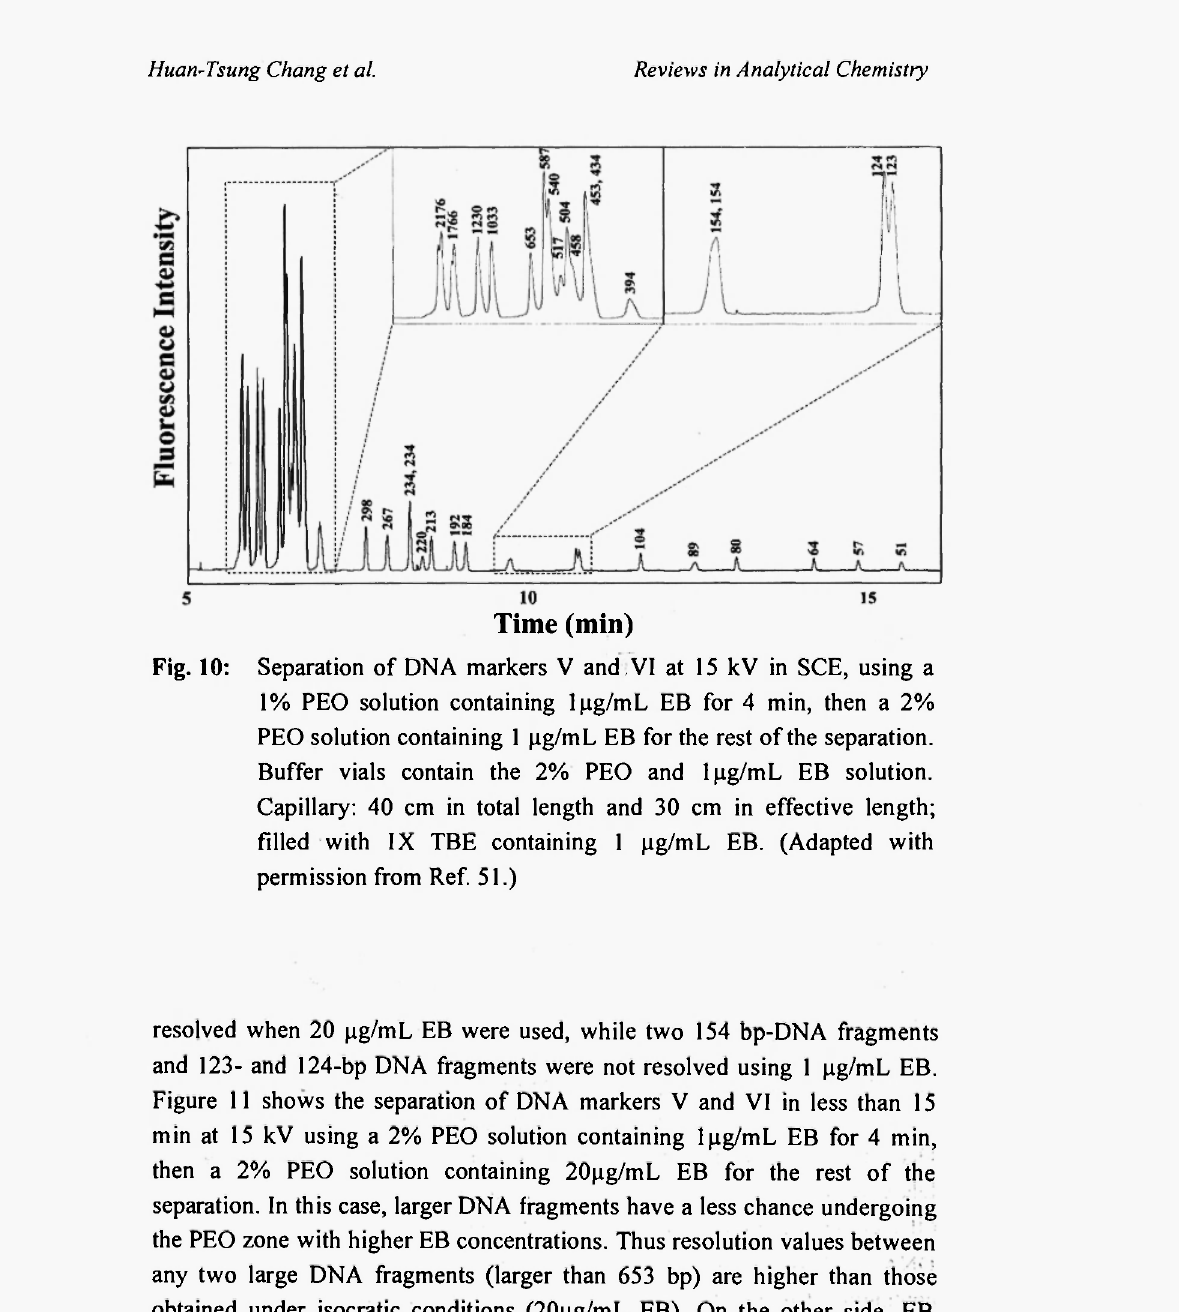
Separation of DNA markers V and VI at 15 kV in SCE, using a 1% PEO solution containing ^ g / mL EB for 4 min, then a 2% PEO solution containing 1 μg/mL EB for the rest of the separation. Buffer vials contain the 2% PEO and ^ g / mL EB solution. Capillary: 40 cm in total length and 30 cm in effective length; filled with IX TBE containing 1 μg/mL EB. (Adapted with permission from Ref.